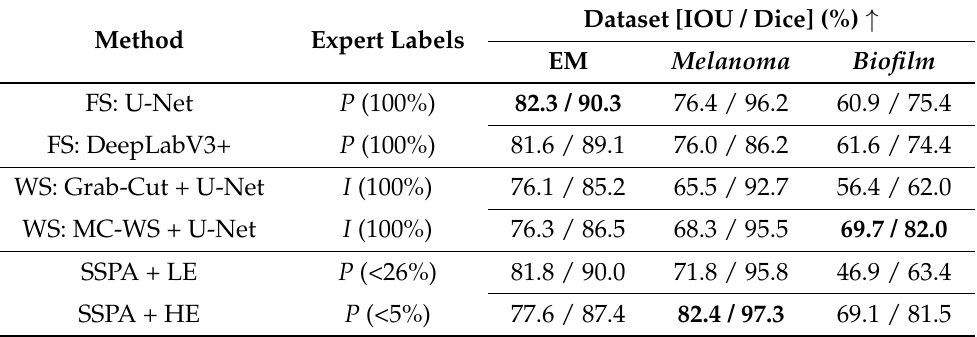
Table 1. Evaluation of the effect of SSPA approach on segmentation quality using both fully super- vised and weakly supervised approaches. Best result is shown in bold. For IOU and Dice score metrics, the higher the number, the better ( ↑ ). I represents the image-level labels and P represents pixel-level labels; percentages are cumulative expert labels across all the iterations of active